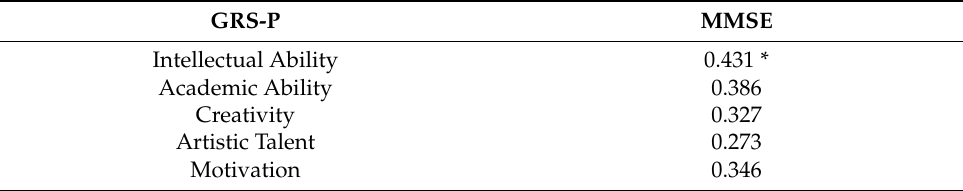
Table 7. Correlations between GRS-P and MMSE.